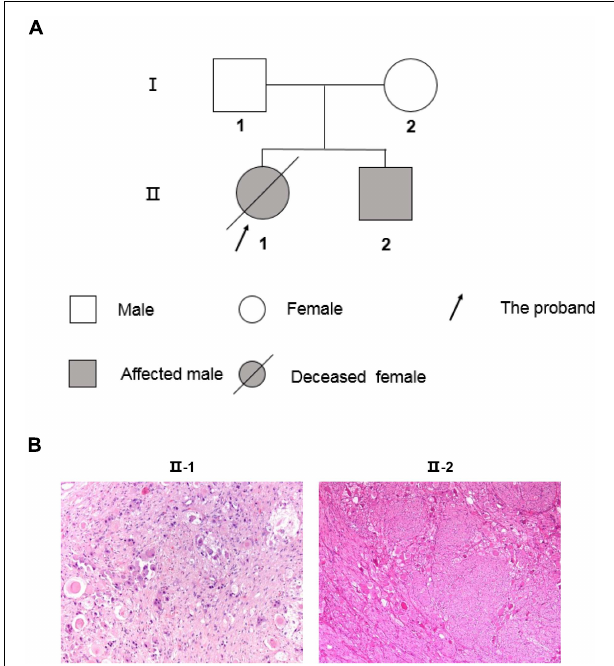
FIGURE 1 | The two-generation pedigree of the family and pathological diagnosis of the PNTs siblings. (A) Solid symbols (squares = males, circles = females) indicate clinically affected individuals, and open symbols indicate unaffected individuals. (B) Histological study confirmed the type of PNTs. II-1 shows the immature neuroblastic tissue from NB after chemotherapy (H&E 100 × ). II-2 shows mature ganglion cells with abundant cytoplasm in a GN (H&E 50 ×